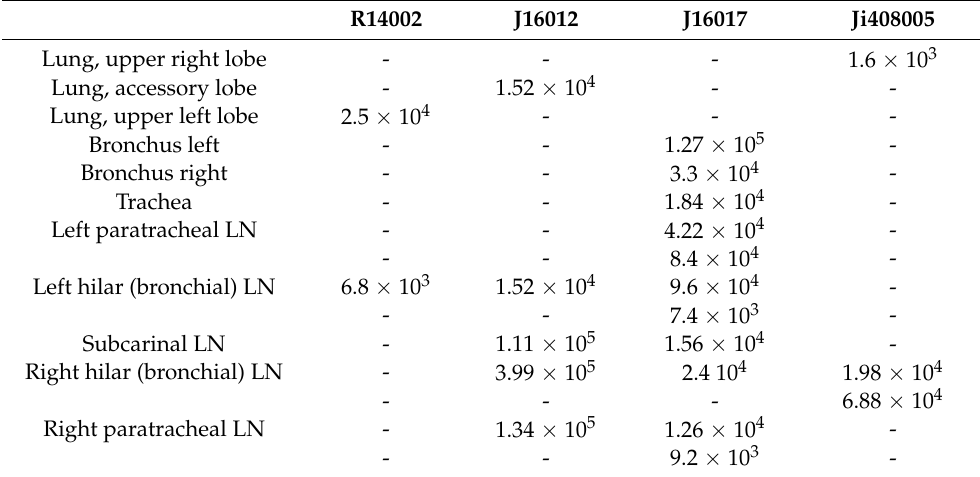
Table 2. Determination of sgmRNA copies per gram of tissue. PCR analysis was done on all tissues that tested positive for SARS-CoV-2 RNA in the RdRp gene assay (Figure 7). Only sgmRNA PCR-positive tissue samples above the LLOQ of 20 RNA copies/reaction are